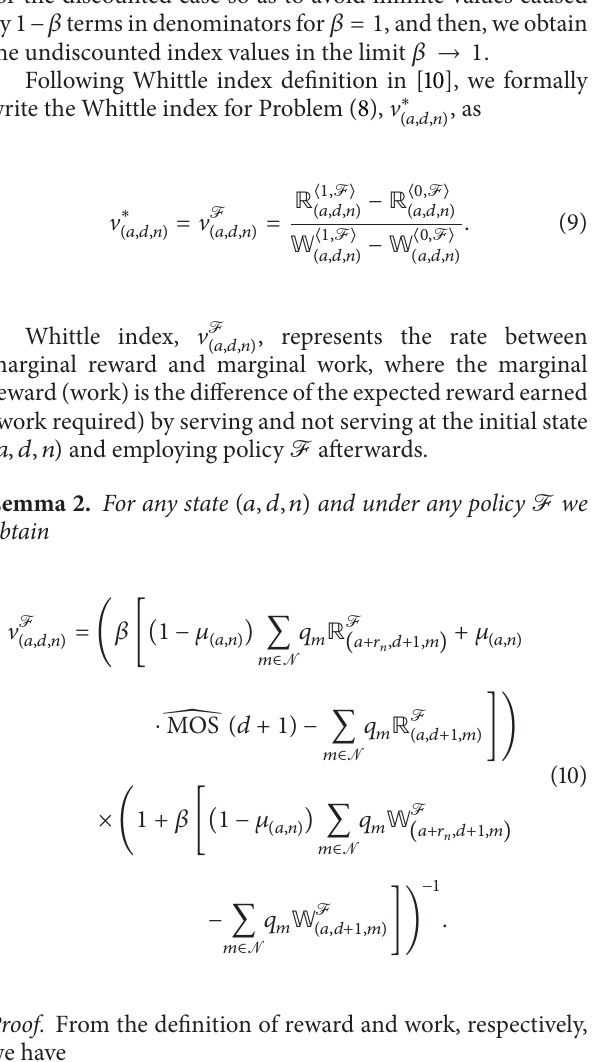
Algorithm 1: AG -algorithm for Problem